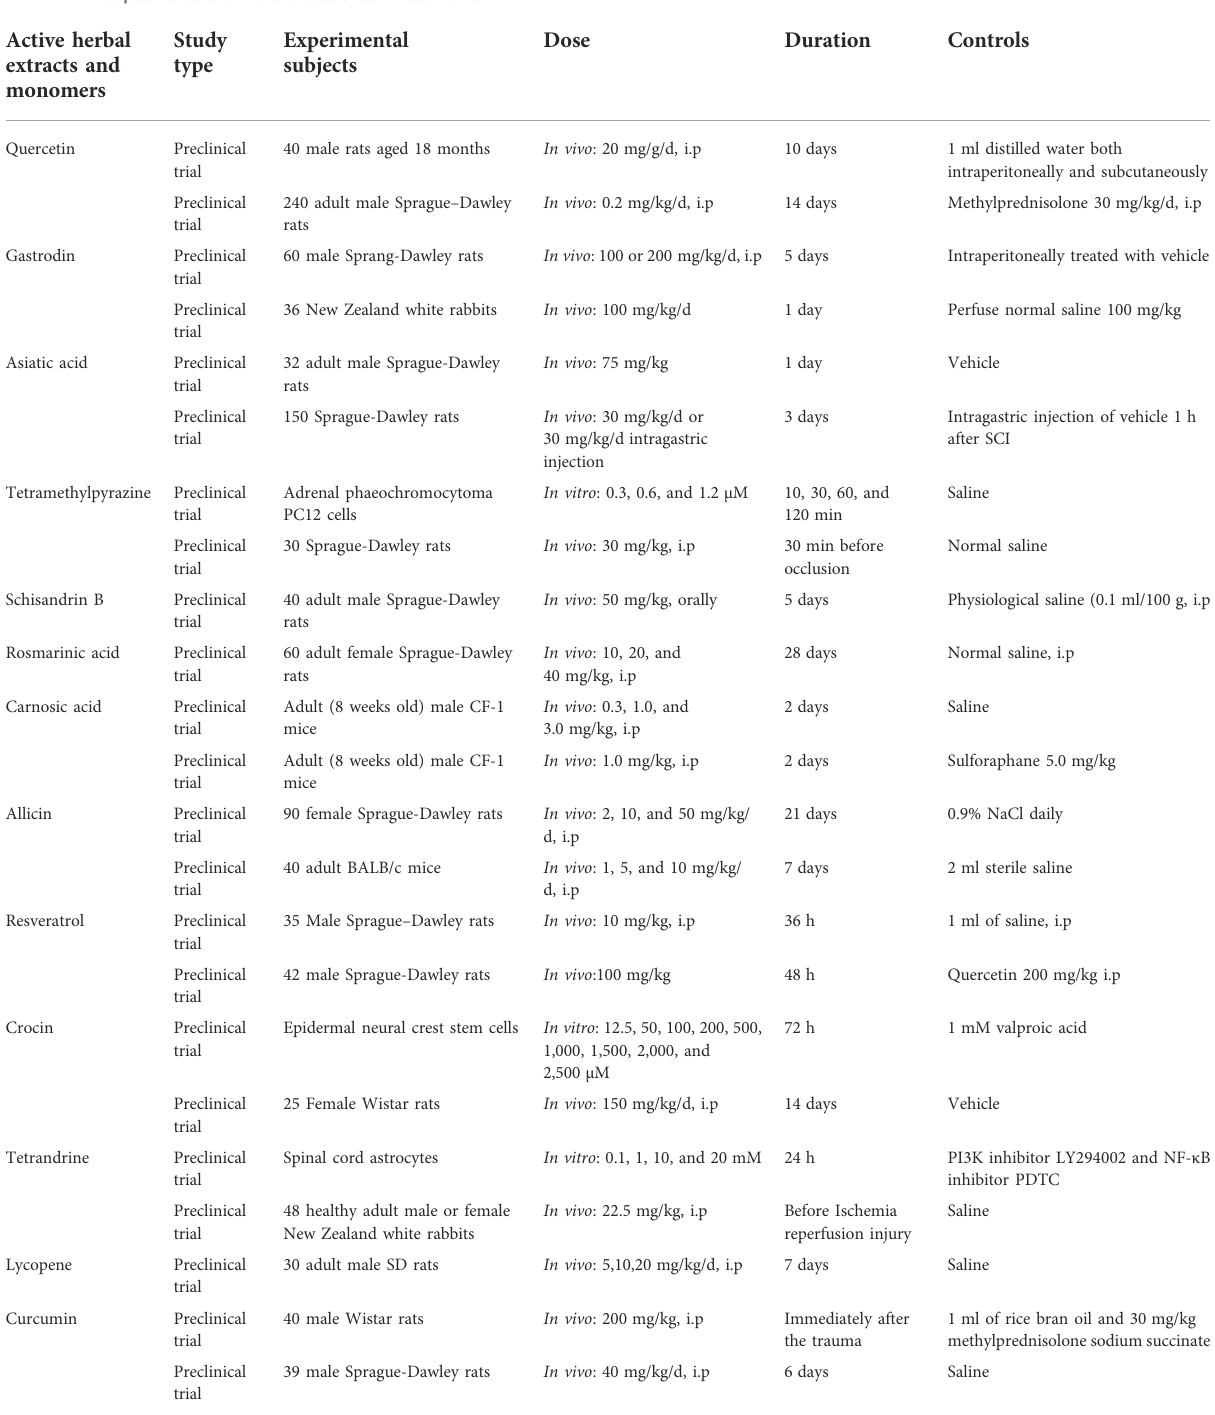
TABLE 2 The speci fi c data of references cited in Section